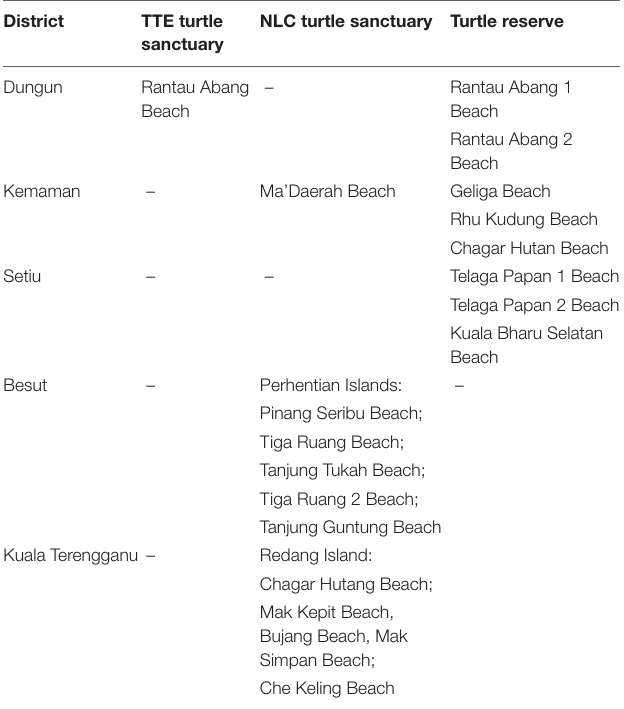
TABLE 4 | List of nesting beaches classified as TTE/NLC turtle sanctuaries or turtle reserves in Terengganu. District TTE turtle NLC turtle sanctuary Turtle sanctuary